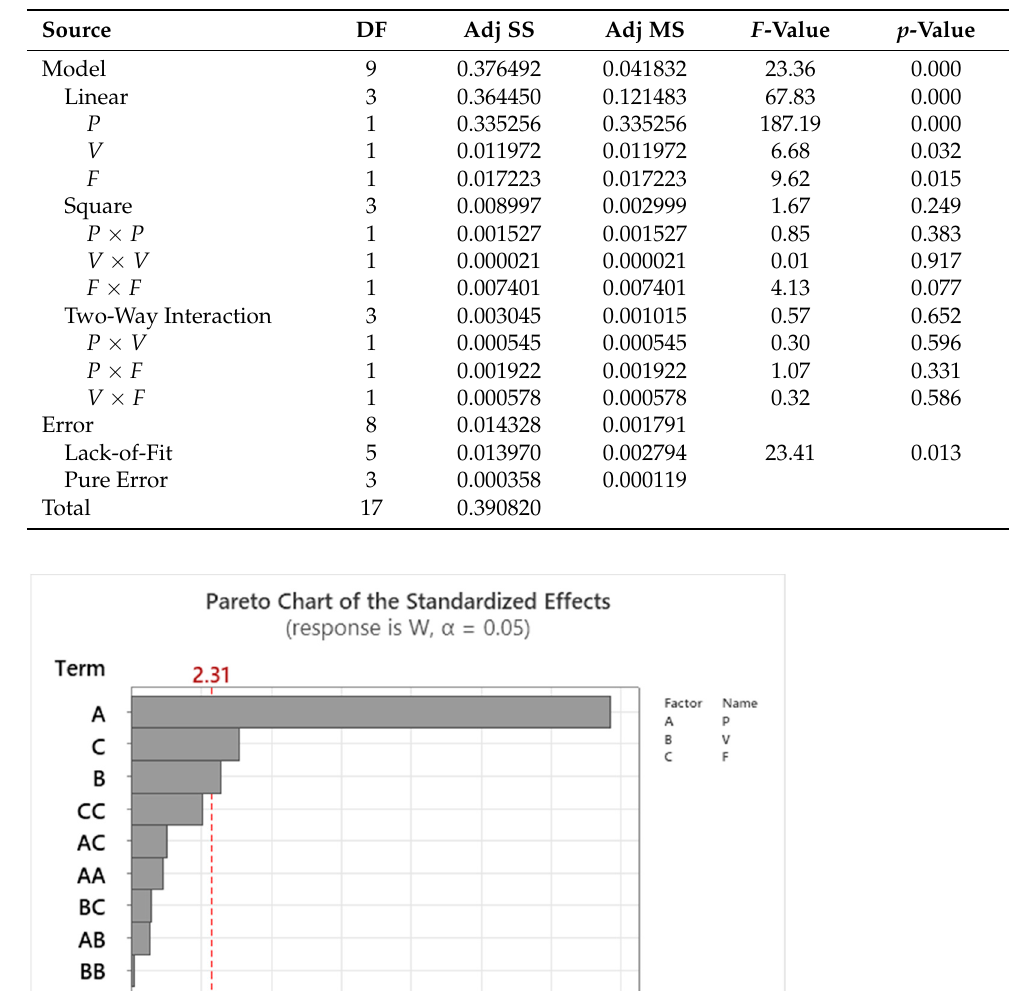
Table 3. ANOVA analysis of W .